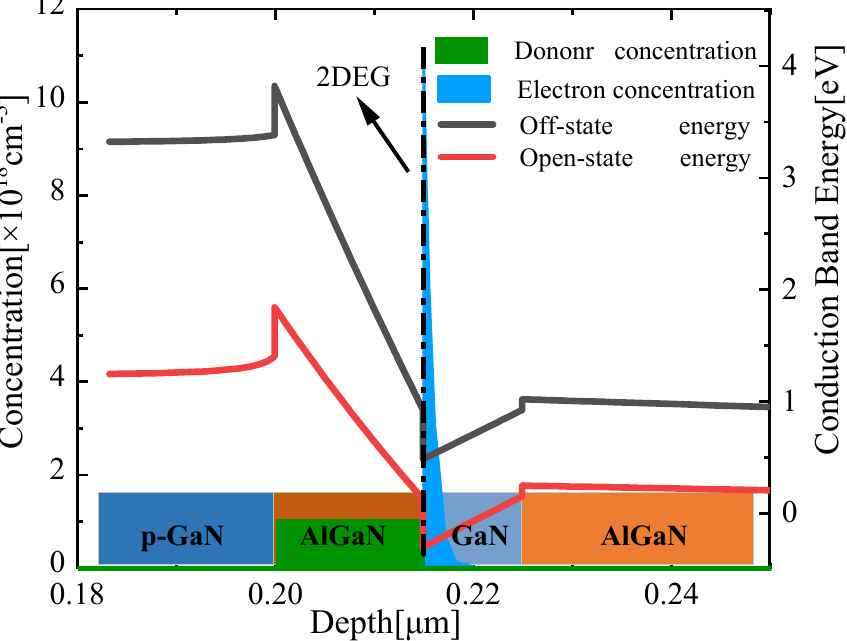
Figure 4. Simulated band diagram (red and grey line, right Y-axis) of the HEMT and electron distribution (green and blue zone, left Y-axis) among different layers.